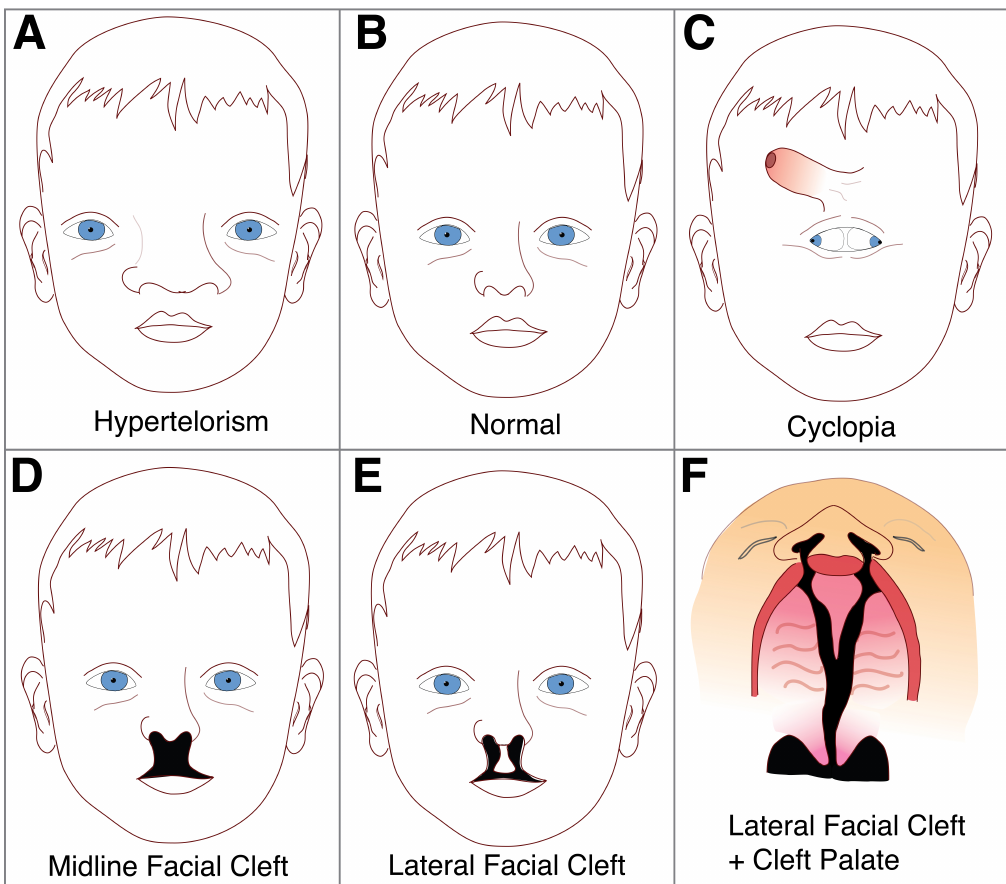
Figure 4. Facial appearances and associated conditions. ( A ) Hypertelorism—abnormally increased distance between eyes, often accompanied by general broadening of midline facial structures. ( B ) Normal, proportionate individual. ( C ) Cyclopia—characterized by undivided or partially divided eye fields, with displacement of the proboscis (putative nose) above the eyes. ( D ) Midline Facial Cleft—facial cleft where the frontonasal mass is reduced and the maxillary prominences do not meet. ( E ) Lateral Facial Cleft—facial cleft where frontonasal mass growth is not reduced, however maxillary prominences failed to fuse. ( F ) Palatal view of a lateral facial cleft. Image adapted from Reference